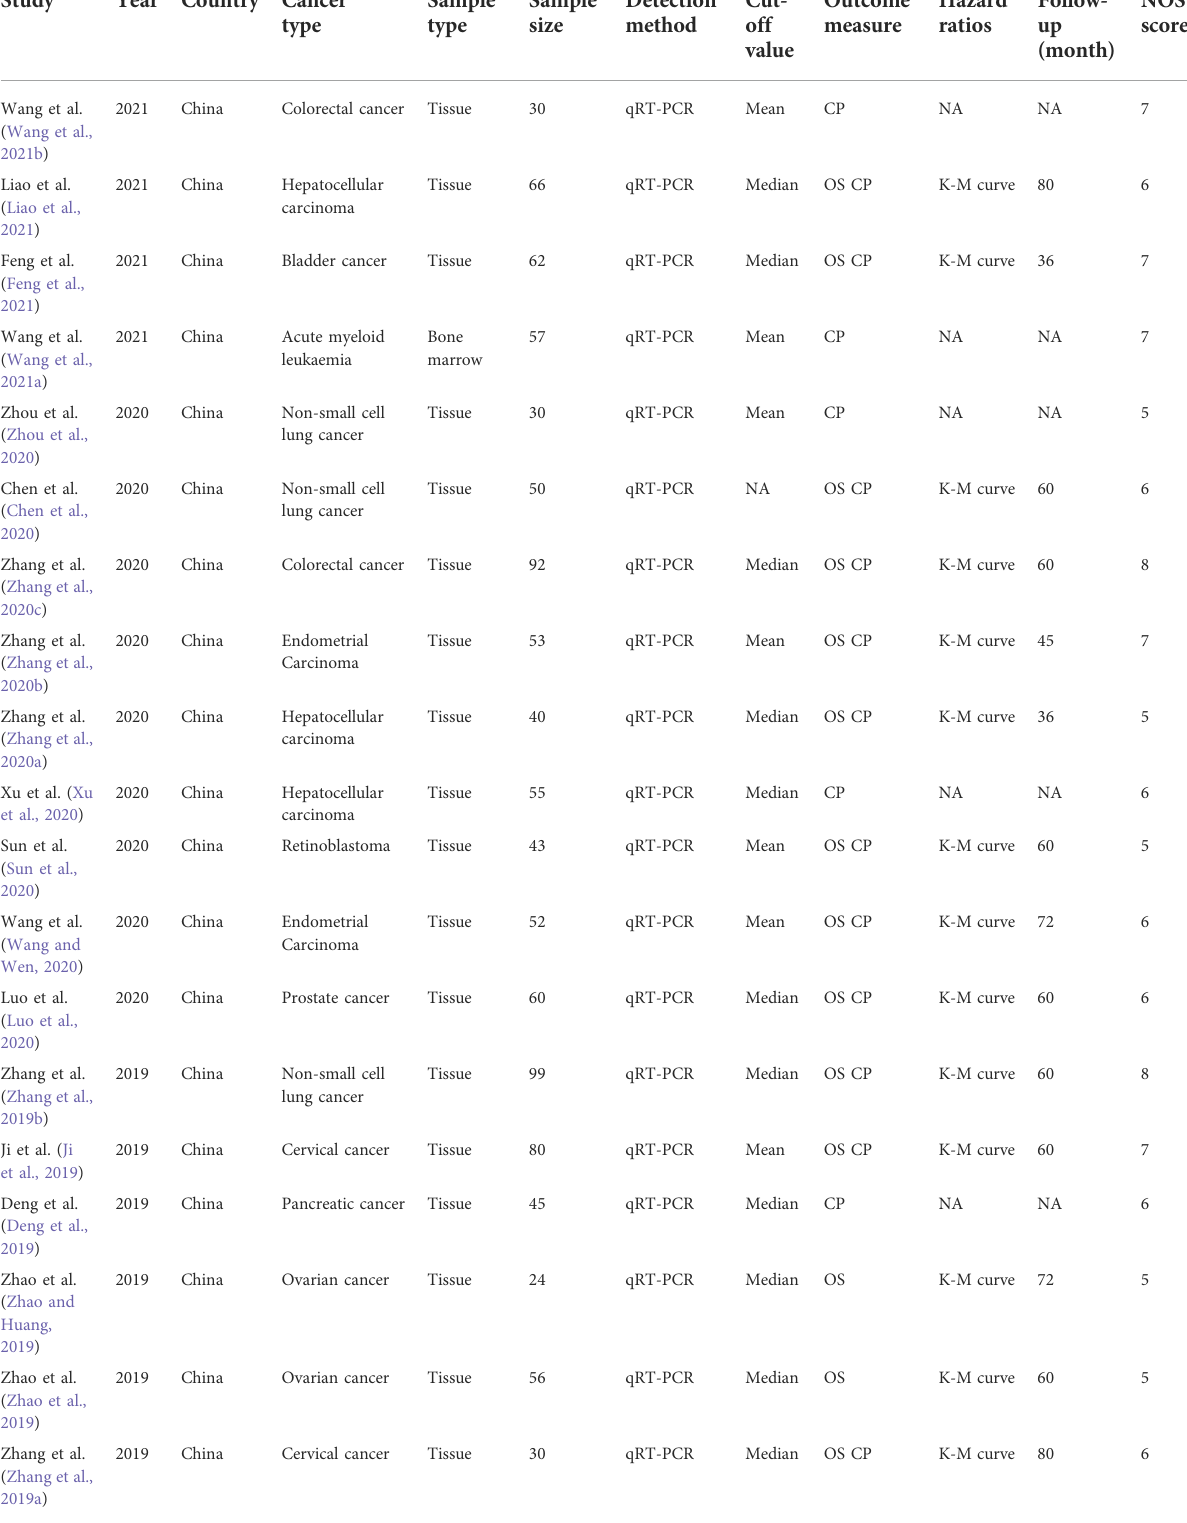
TABLE 1 Characteristics of included